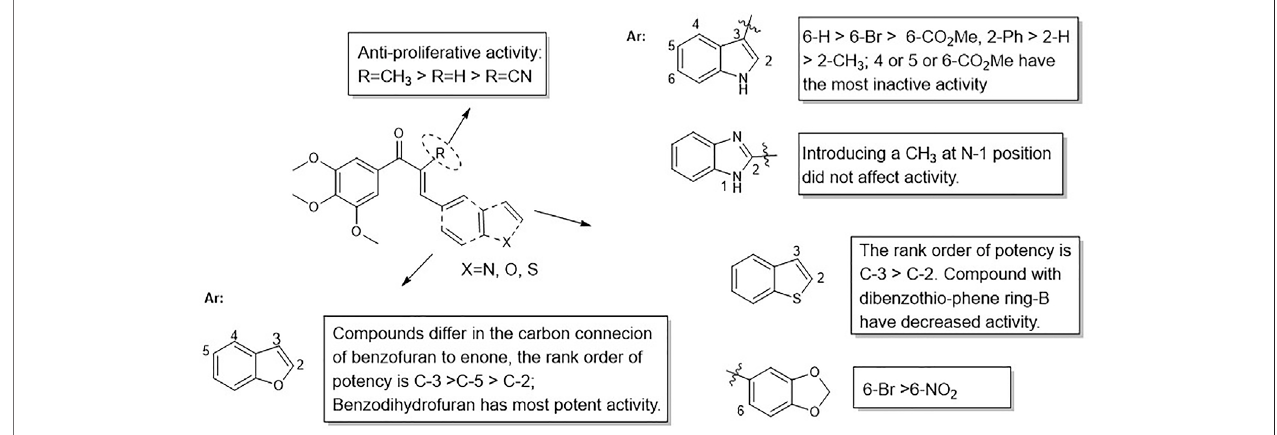
FIGURE 2 | Summarized SARs of synthesized chalcone analogs.